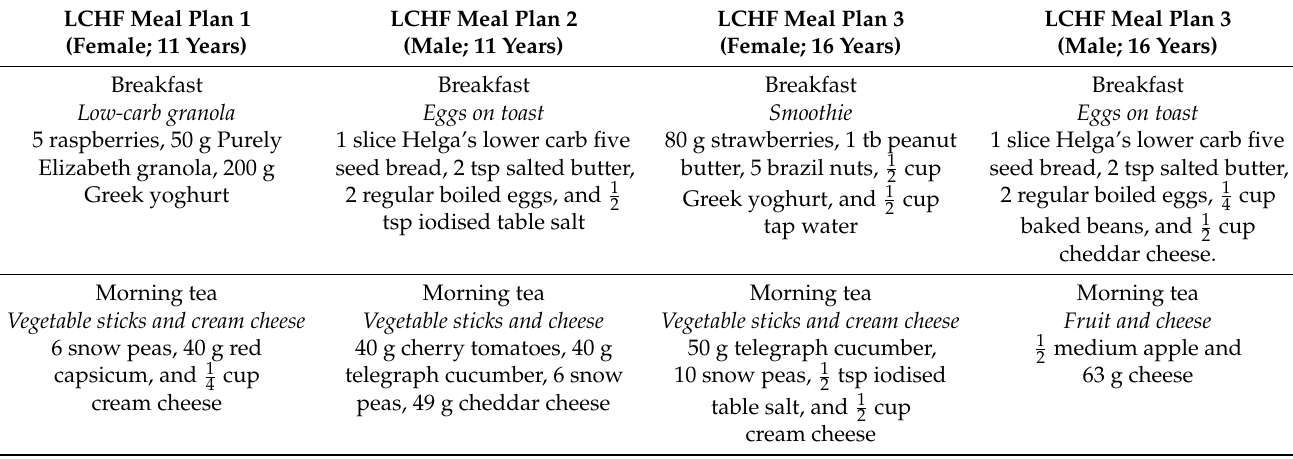
Table 2. LCHF sample meal